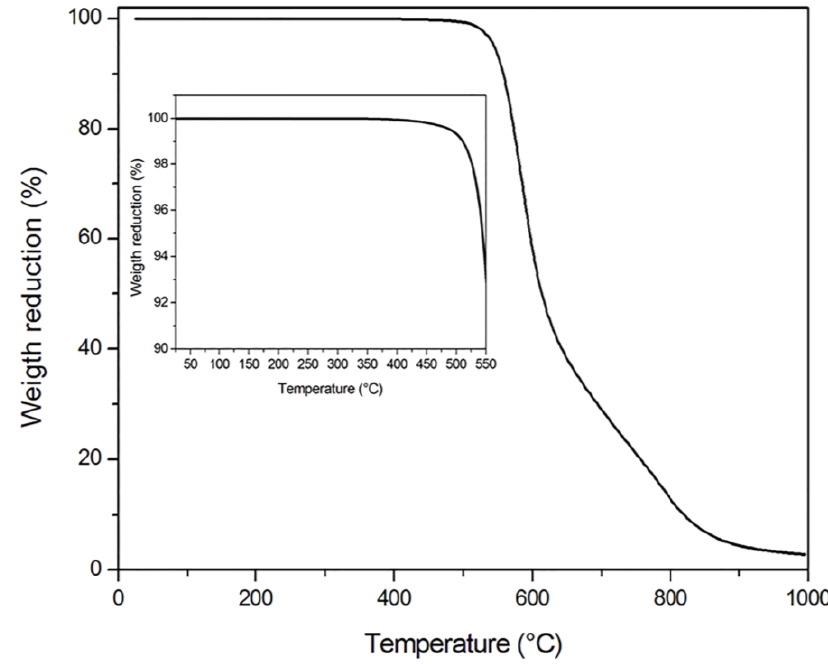
Figure 6. TGA thermogram in air on autoclave-consolidated blank composites.